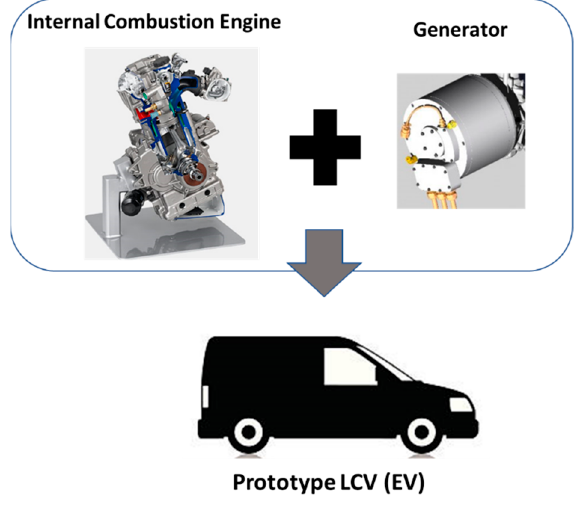
Figure 1. Prototype light commercial EV, ICE and generator.